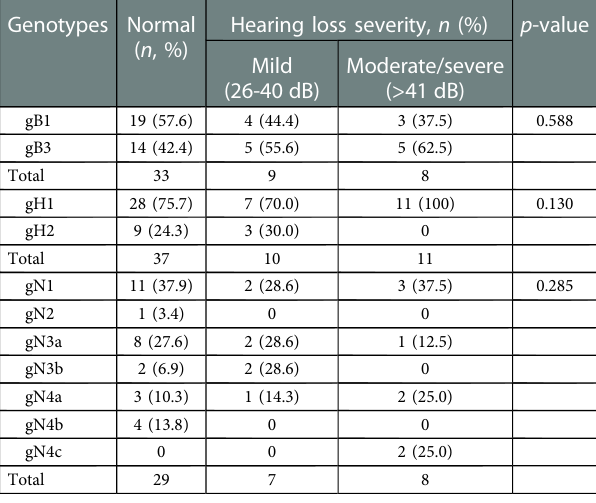
TABLE 3 Distribution of gB, gH and gN genotypes among symptomatic cCMV infected children with different hearing loss severities. Genotypes Normal ( n ,